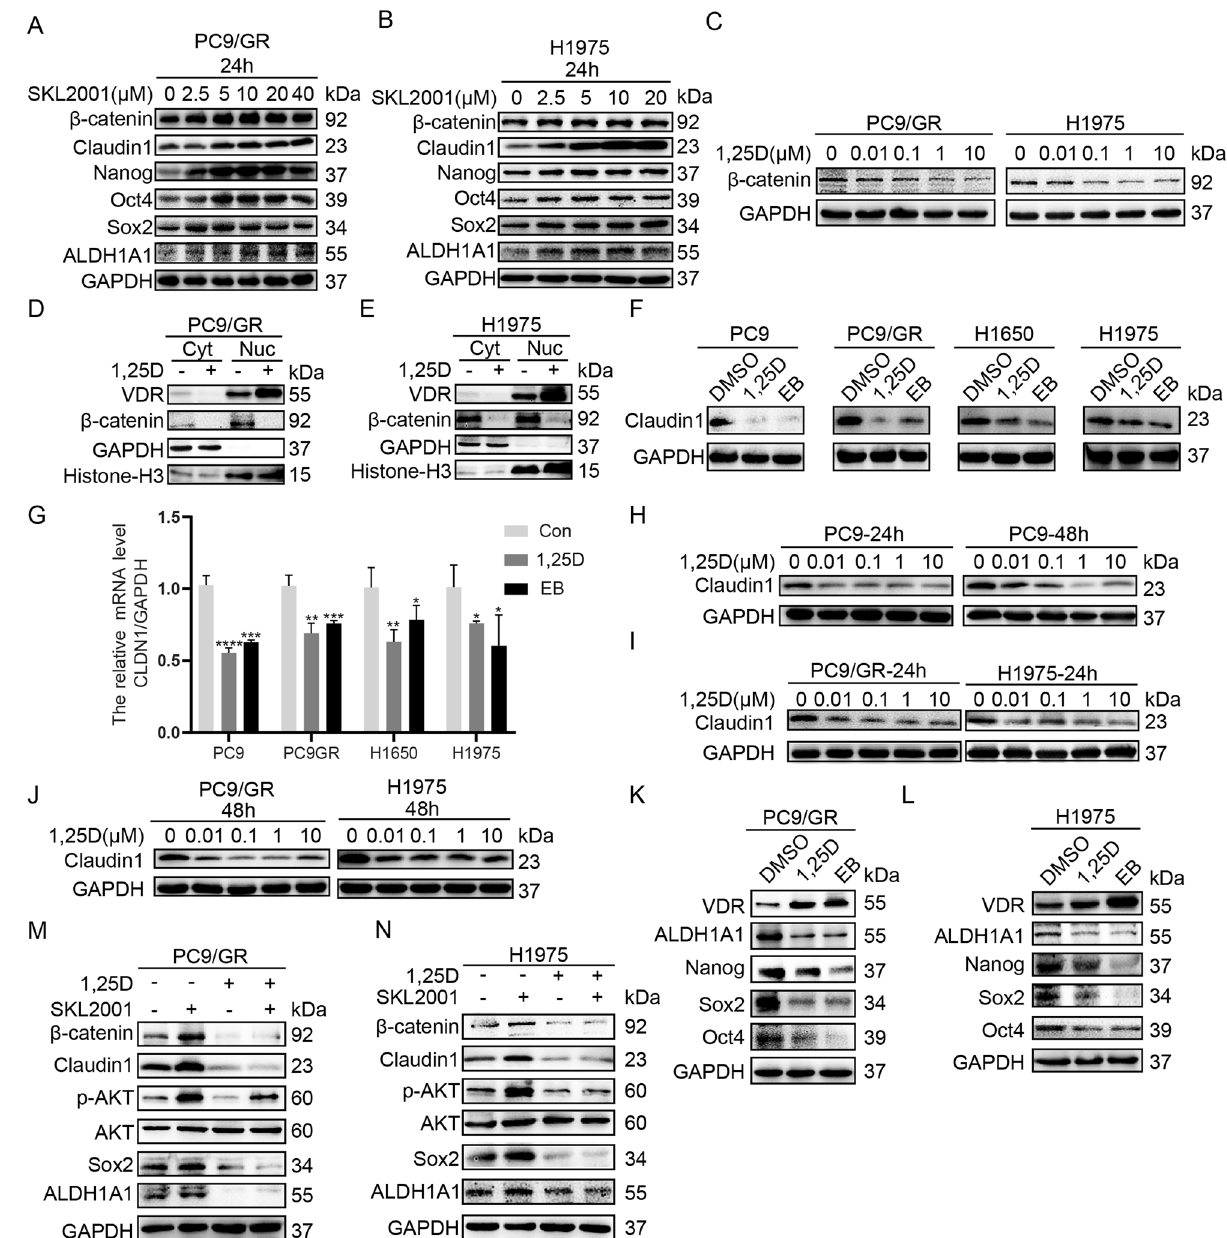
Fig. 6 1,25D inhibits claudin1/AKT/cancer cell stemness pathway by inhibiting β -catenin activation. A , B PC9/GR and H1975 cells were stimulated with various concentrations of SKL2001 for 24 h, then the expression levels of claudin1, Nanog, Oct4, Sox2, and ALDH1A1 were determined. C PC9/GR and H1975 cells were treated with various concentrations of 1,25D after which β -catenin level was determined by western blotting. D , E Nuclear and cytoplasmic fractions of PC9/GR and H1975 cells in the presence or absence of 1,25D were prepared, and VDR and β -catenin expression levels were determined by western blotting. GAPDH and Histone-H3 were, respectively, used as cytoplasm and nucleus loading controls. F Expression levels of claudin1 were determined after PC9, PC9/GR, H1975, and H1650 cells were treated with DMSO, 1,25D (100 nM), or EB (100 nM) for 48 h. G Relative mRNA expression levels of CLDN1 were detected by real-time PCR after PC9, PC9/GR, H1650, and H1975 cells had been treated with 1,25D or EB (mean ± SD; n = 6; * P < 0.05, ** P < 0.01, *** P < 0.001, **** P < 0.0001). H – J PC9, PC9/GR, and H1975 cells were treated with various concentrations of 1,25D, respectively, for 24 and 48 h after which claudin1 protein expression was evaluated. K , L PC9/GR and H1975 cells were treated with DMSO, 1,25D (100 nM), or EB (100 nM) for 48 h, then the expression levels of VDR, ALDH1A1, Nanog, Oct4, and Sox2 were evaluated by western blotting. M , N PC9/GR and H1975 cells were, respectively, treated with 1,25D, SKL2001, or a combination of 1,25D and SKL2001, and the expression levels of β -catenin, claudin1, p-AKT, Sox2, and ALDH1A1 were determined. Sox2, Oct4, and Nanog [12]. In addition, inhibition of stem cell-like EGFR-TKIs resistance [24, 25]. ALDH1A1-positive lung cancer cells properties or knockdown of stem cell-related markers restores were shown to exhibit resistance to ge fi tinib when compared to EGFR-TKIs cytotoxicity [11, 27]. Notably, we found that claudin1 ALDH1A1-negative lung cancer cells [26]. LUAD resistance to downregulation inhibited the expression levels of Oct4, Nanog, EGFR-TKIs therapy is associated with increased expression levels of